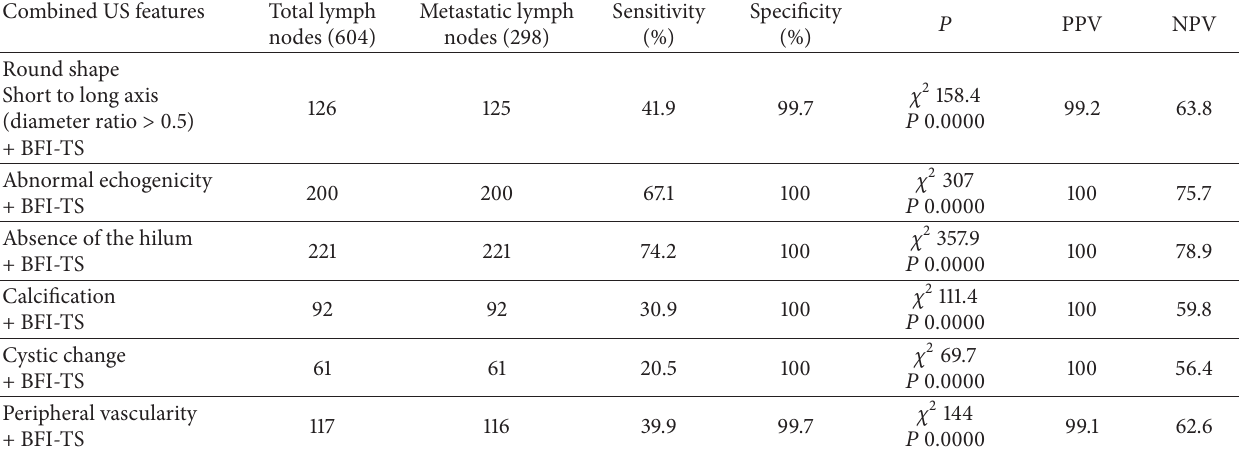
Table 2: The diagnostic performance of the combination of each conventional ultrasound signs with the BFI-TS.